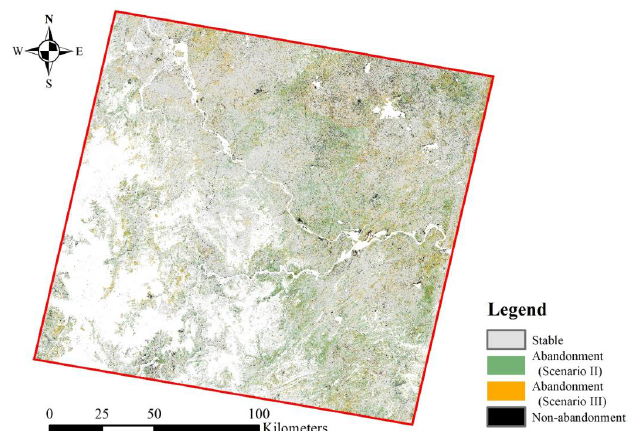
Figure 9. Trajectory types produced by the decision tree model (Figure 5). The abandoned croplands are in green and orange, corresponding to Scenarios II and III, respectively. The non-abandoned croplands are in grey (Scenario I) and black (Scenario IV).